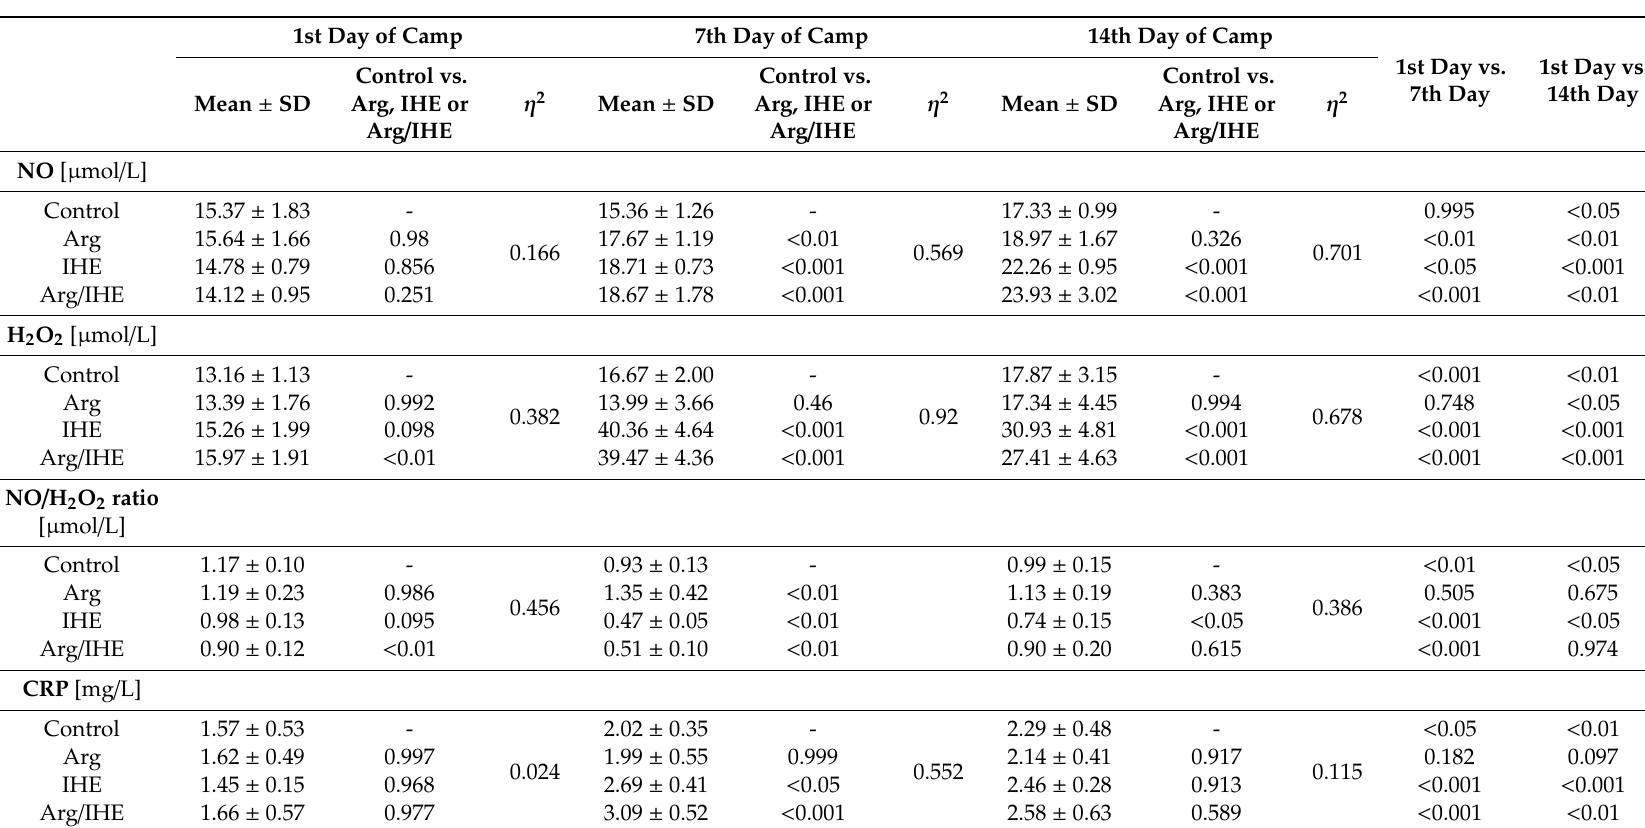
Table 2. The levels of oxi-inflammatory